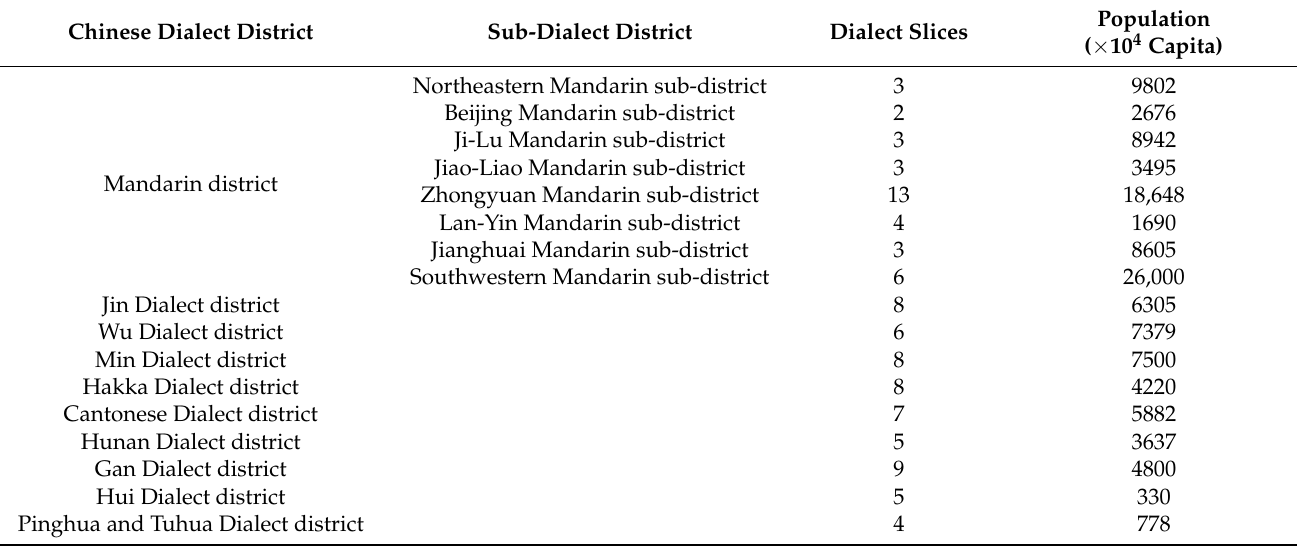
Table 2. Chinese dialect districts and their corresponding dialect slices, population.